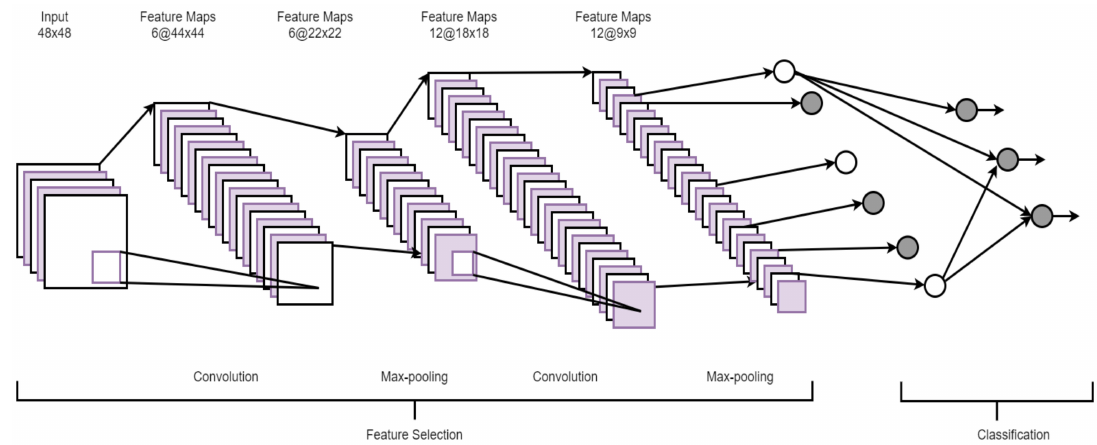
Figure 4. An architecture of a convolutional neural network (CNN) (adopted from [39]).